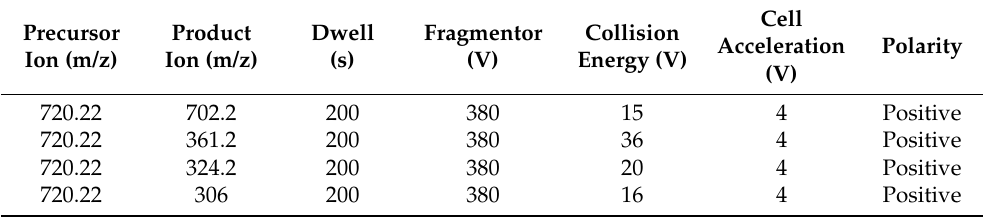
Table 1. Multiple Reaction Monitoring (MRM) scan parameters for the optimised epirubicin glu- curonide